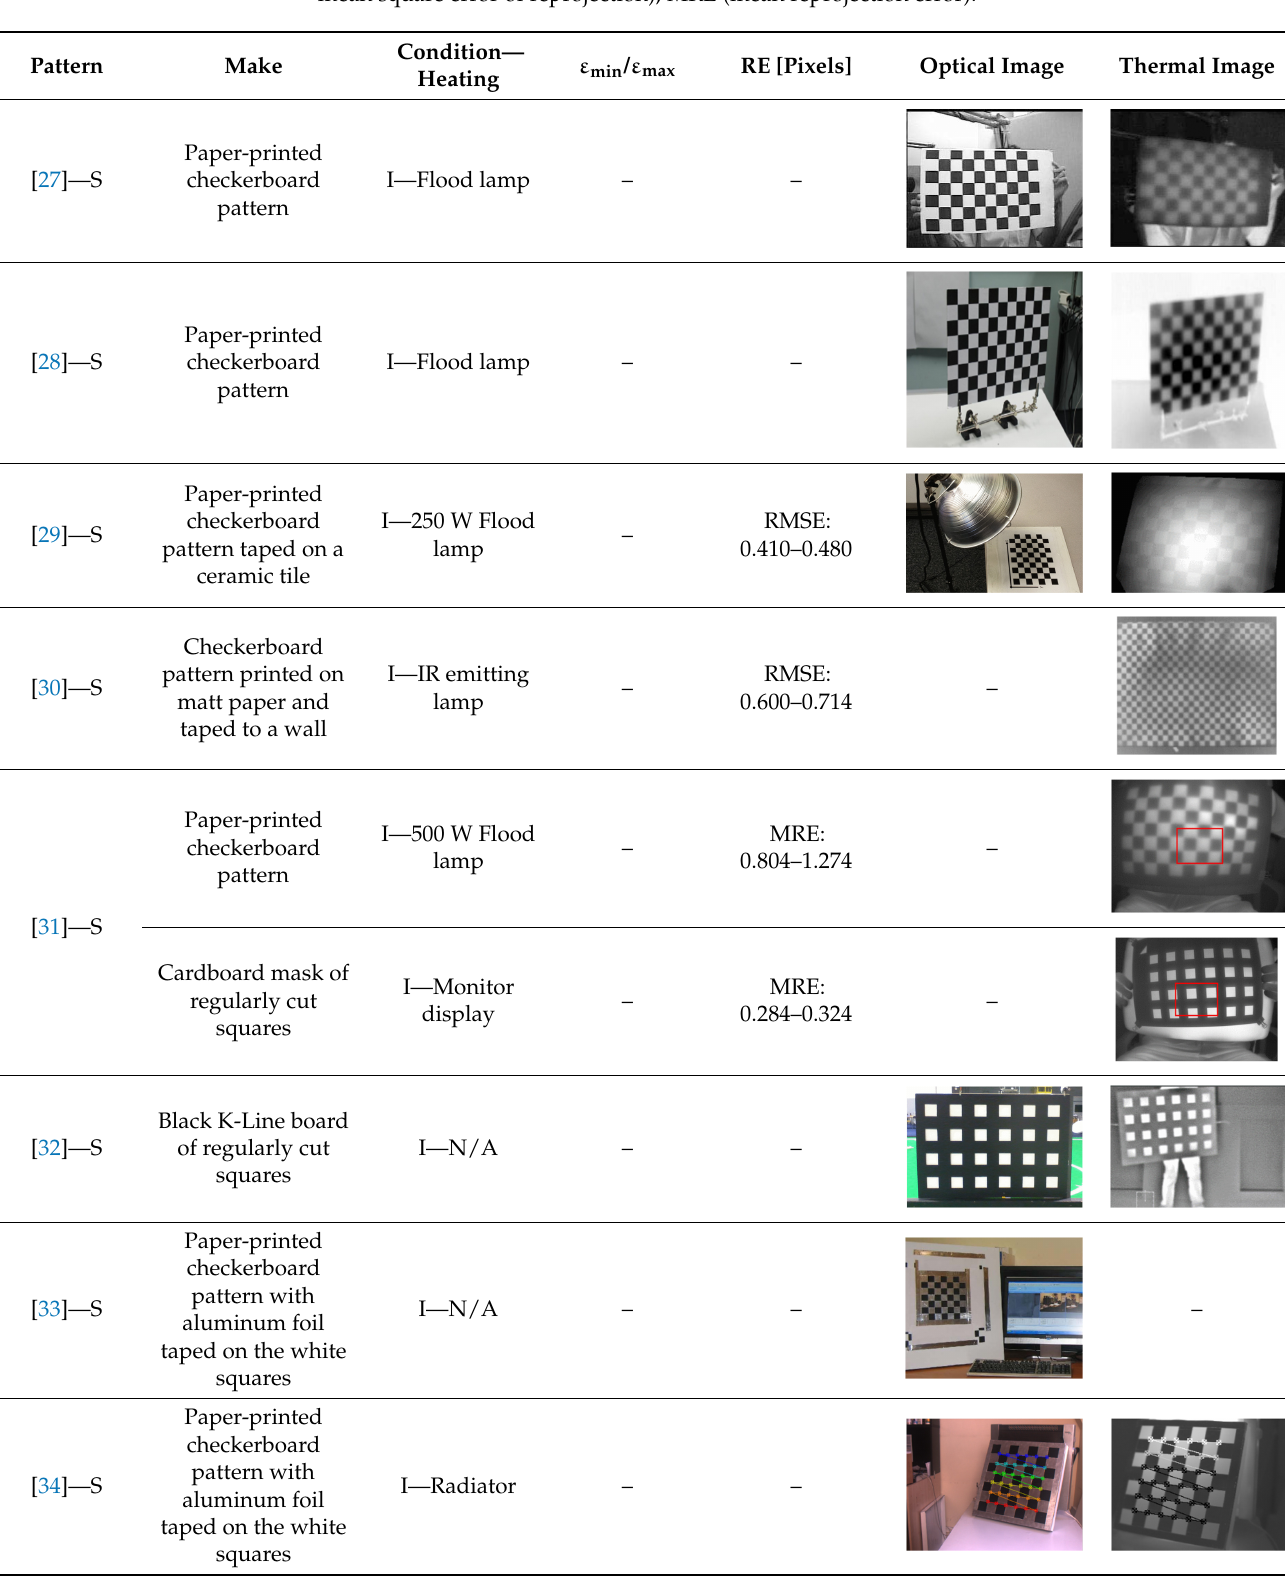
Table 1. Summary of reported thermal camera geometric calibration targets. Pa tt ern: S (square) and C (circular); condition: I (indoor) and O (outdoor); ε min / ε max : (lowest/highest emissivity coe ffi cients of pa tt ern); heating: N/A (not available) and NI (no information); RE (reprojection error); RMSE (root mean square error of reprojection); MRE (mean reprojection error).